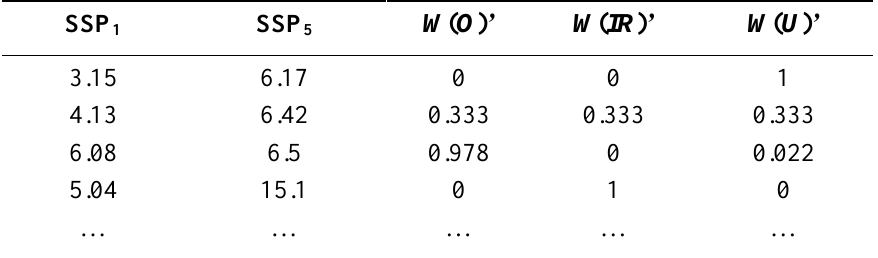
Table 7. Training data for second step of sequential diagnosis.